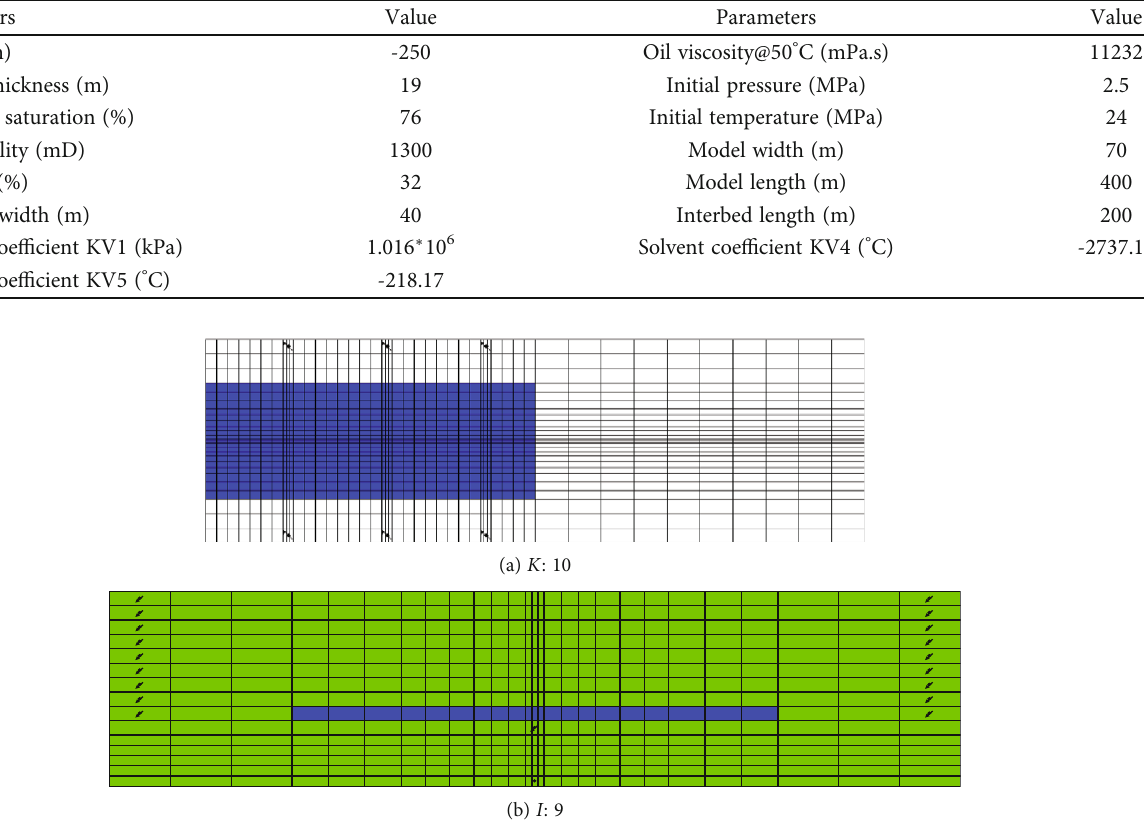
Figure 12: Dynamics comparison of di ff erent CSS-assisted SAGD. Table 2: Parameters of the model and fl uid.